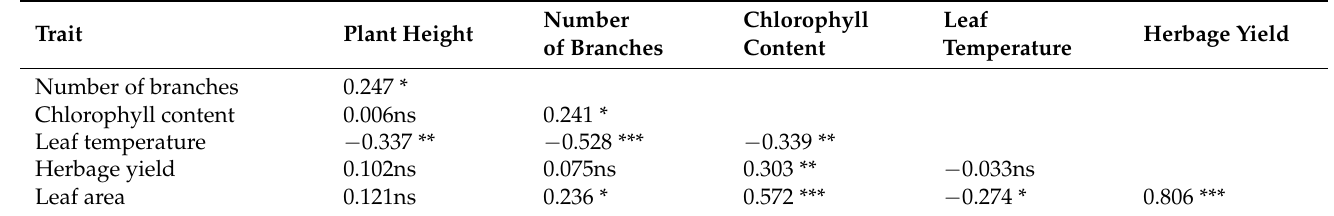
Table 8. Pearson’s correlation coefficient (r) between plant growth and physiological